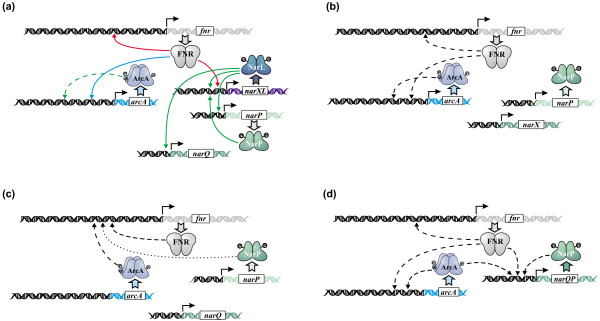
Respiration regulatory cascades in gamma-proteobacteria. (a) E. coli; (b) Yersinia spp.; (c) Pasteurellaceae; (d) Vibrionaceae. Experimentally determined regulation is shown by continuous arrows: green, activation; red, repression; blue, ambivalent regulation. Predicted regulation is shown by broken arrows: green, activation; black, type of regulation is not determined. Dotted arrows in (c): sites were not found in H. ducreyi.